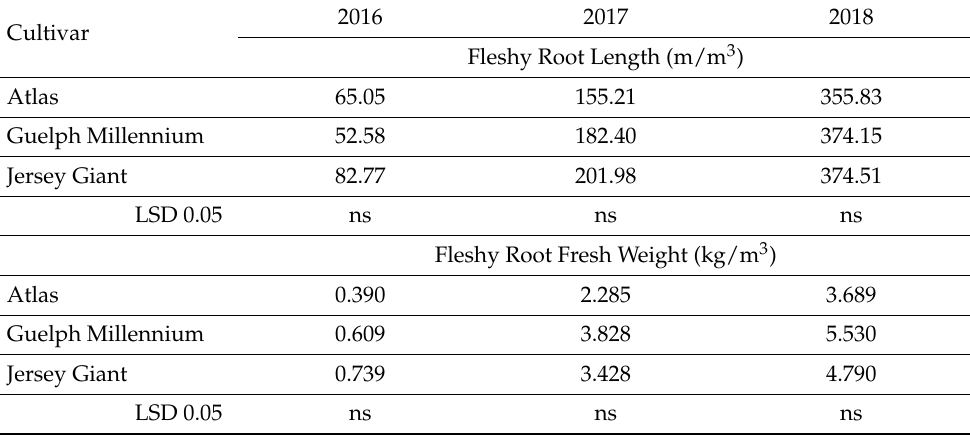
Table 2. Effect of asparagus ( Asparagus officinalis ) cultivars (Atlas, Guelph Millennium, Jersey Giant) on estimated total fleshy storage root length (m/m 3 ) and fresh weight (kg/m 3 ) during the estab-